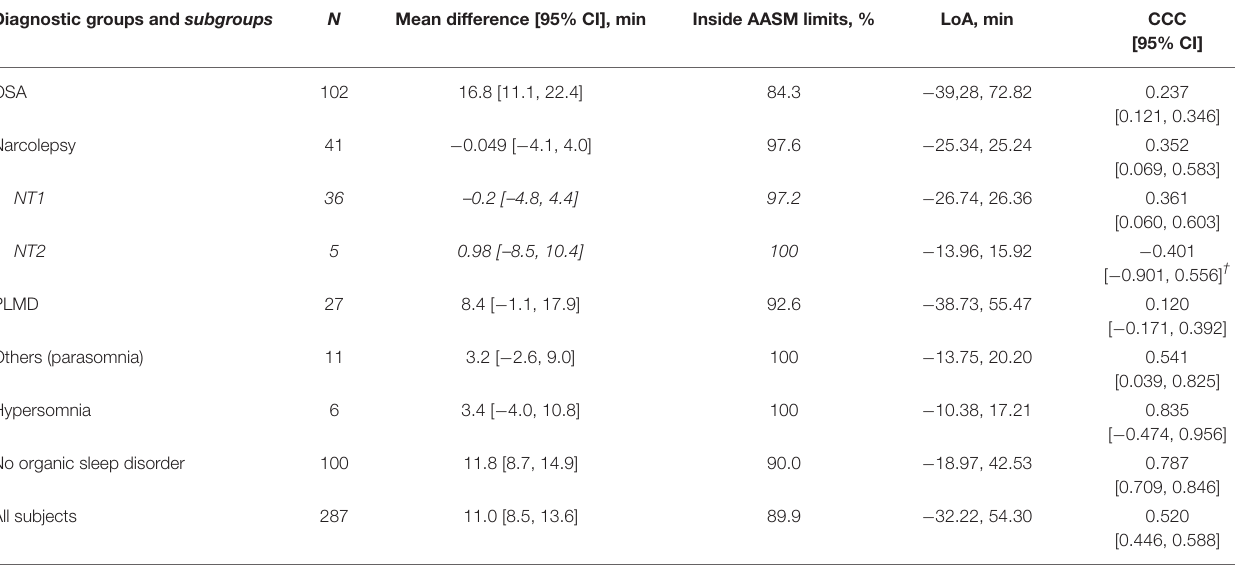
TABLE 4 | Concordance of sleep latency between actigraphy and ambulatory polysomnography. Diagnostic groups and